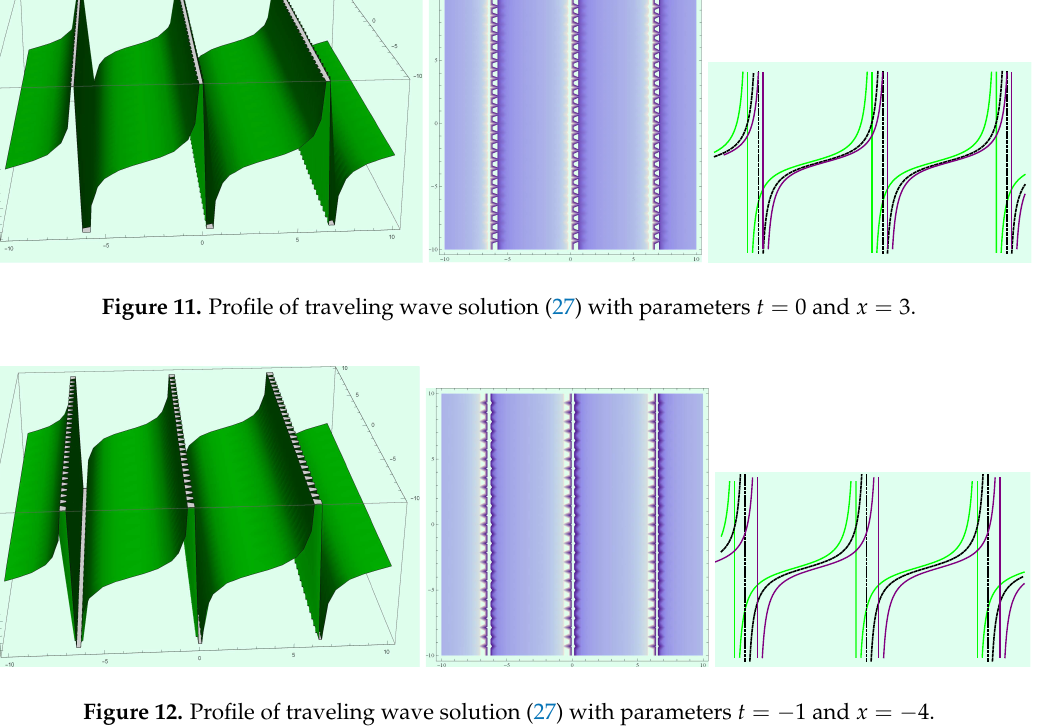
Figure 12. Profile of traveling wave solution (27) with parameters t = − 1 and x = −